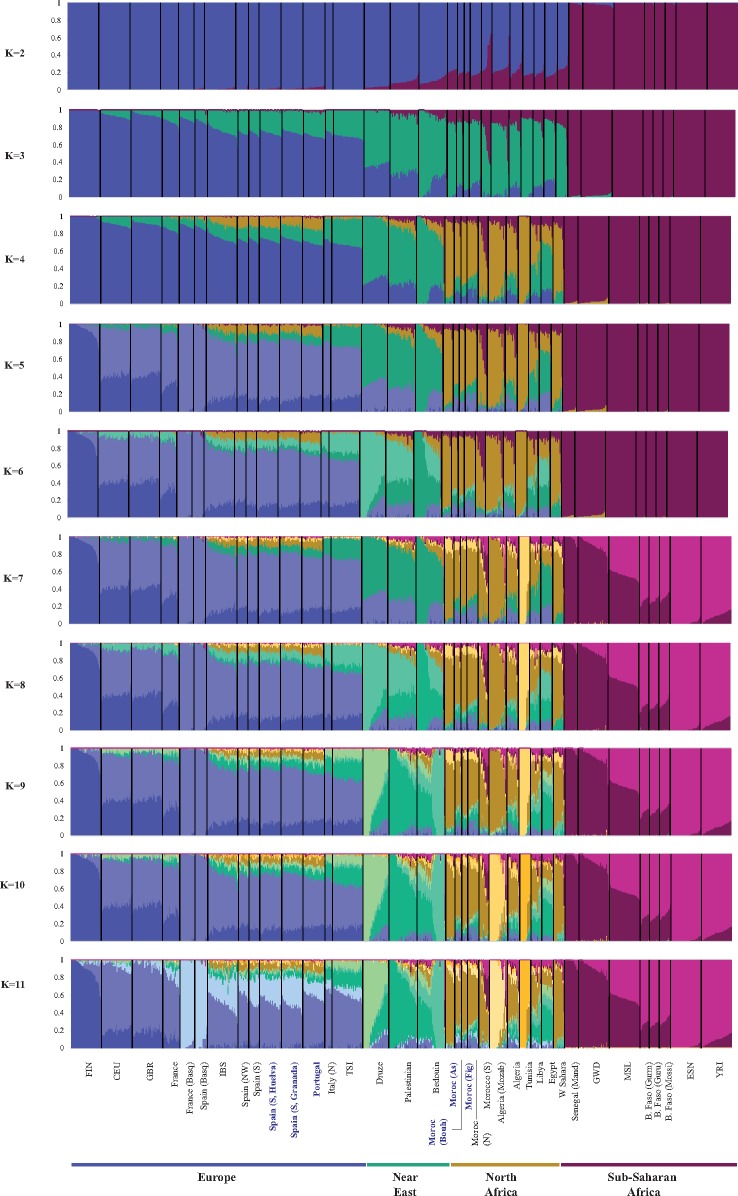
Ancestry proportions for ADMIXTURE analysis with a variable number of ancestral clusters (K = 2–11). See references and details on populations in supplementary table S8, Supplementary Material online. Population samples analyzed in the present study are highlighted in blue bold face. Best-fitting model is K = 5.